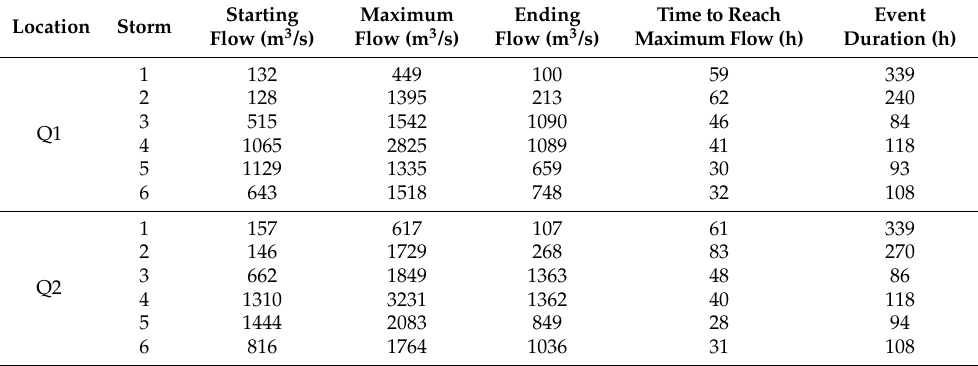
Table 2. Characteristics of six rainstorms at Q1 and Q2 locations along the Kanawha River.